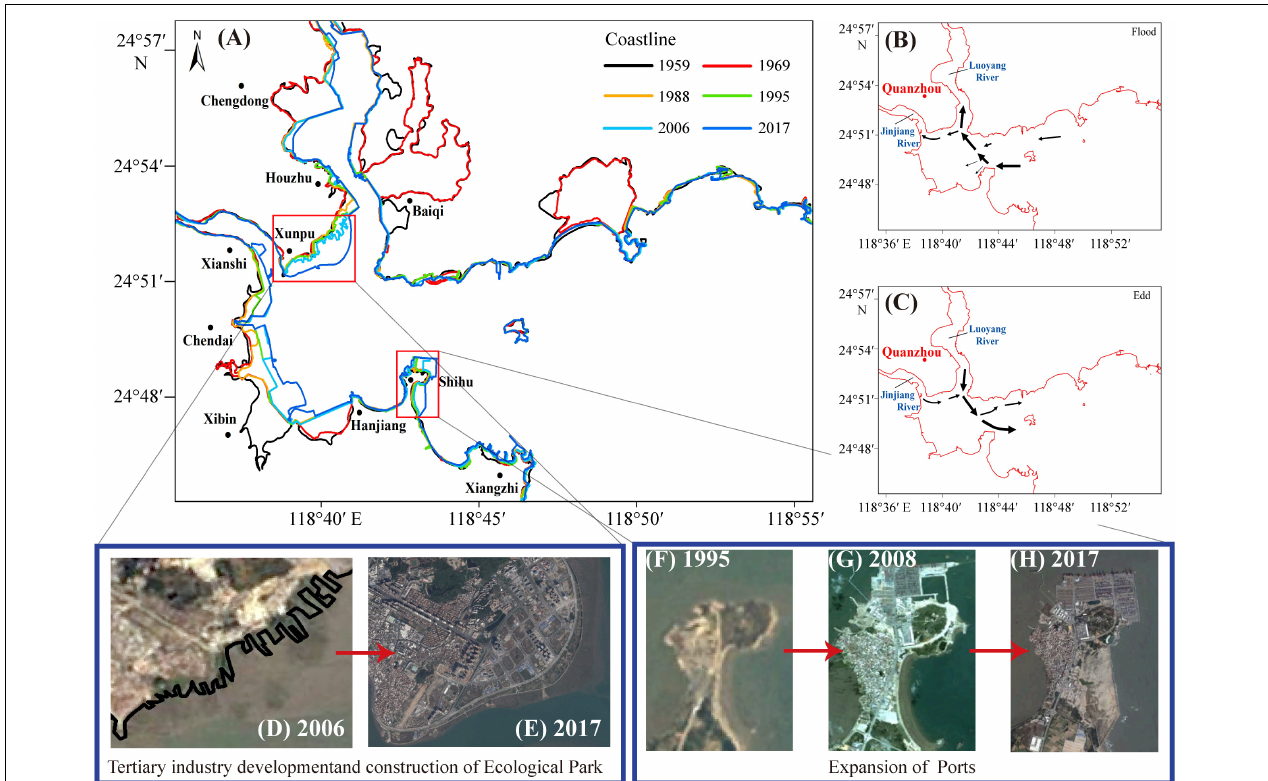
FIGURE 2 | Tidal current direction, coastline and reclamation changes in Quanzhou Bay. (A) Coastline change; (B) Flood current; (C) Ebb current; (D,E) Urban expansion in Fengze; (F–H) Shihu Port expansion [ (D–H) images are from Google Earth Pro].